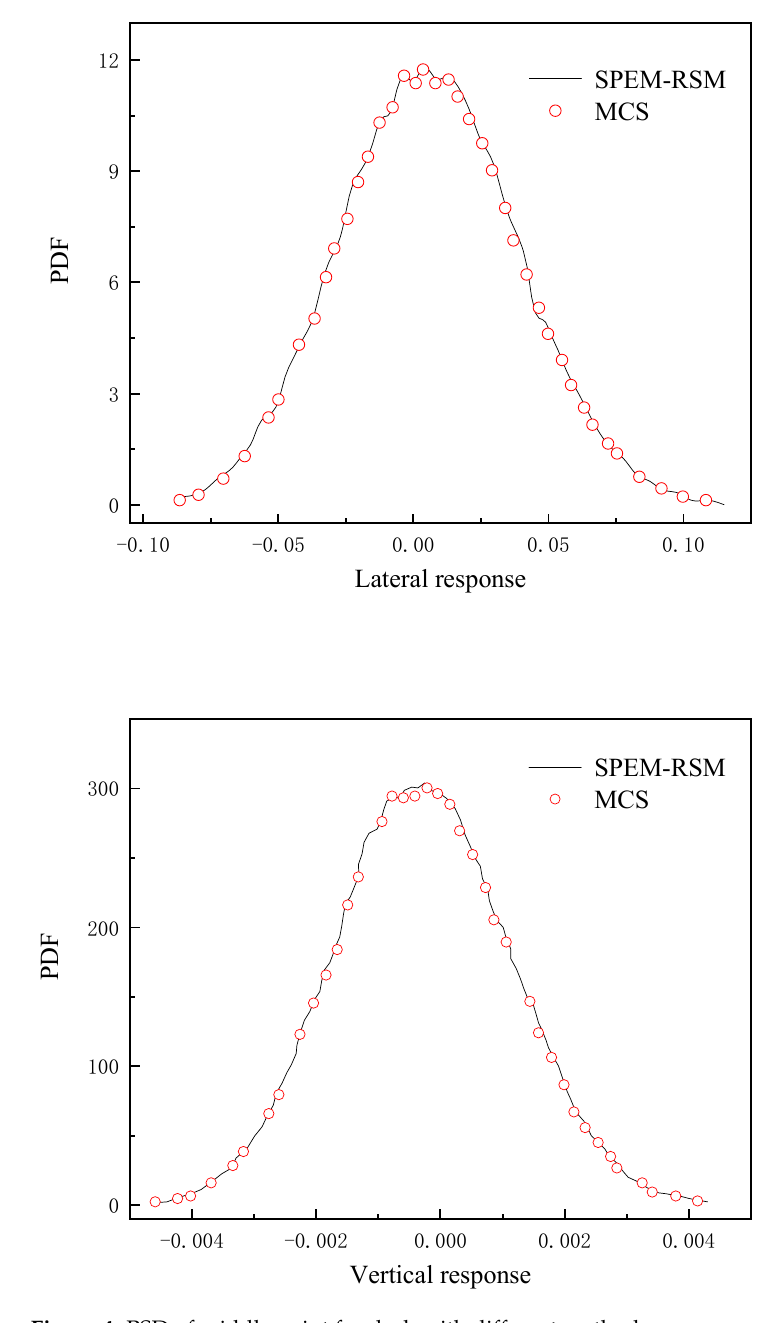
Figure 4. PSD of middle point for deck with different method.